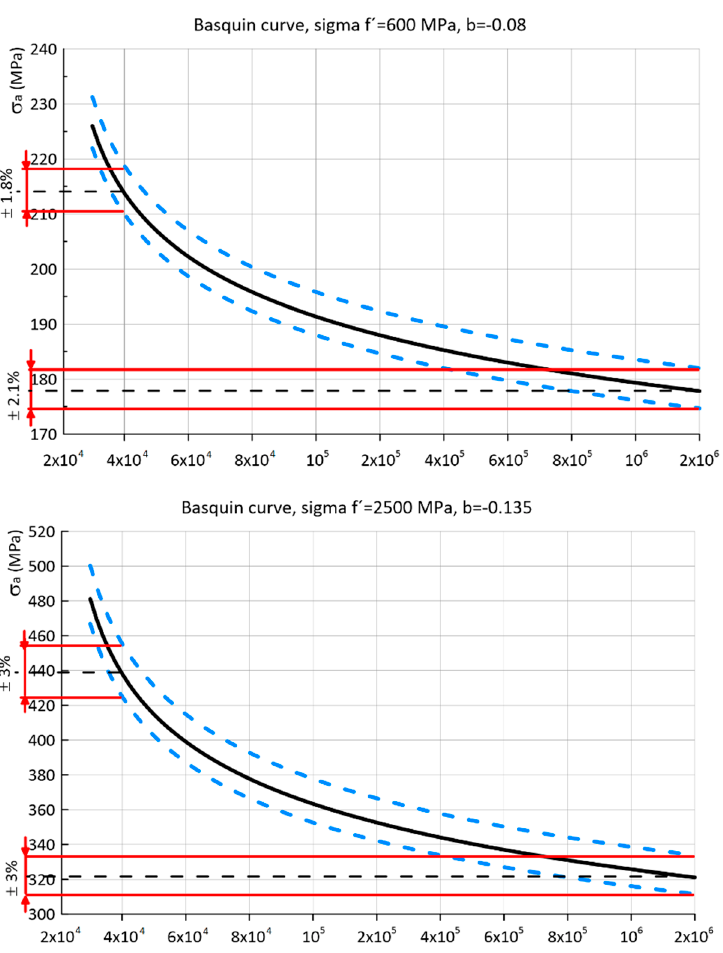
Figure 7. Determination of the permissible error for the calculation of the stress amplitude.